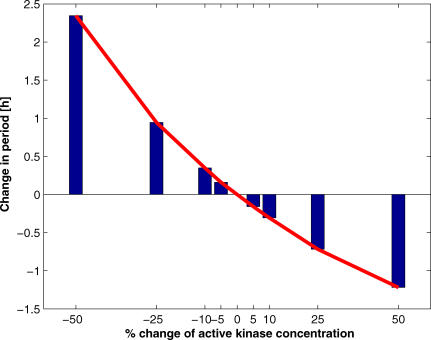
Changes in the Period as a Result of Variation in Kinase CK1 ConcentrationAll other parameters remained constant.